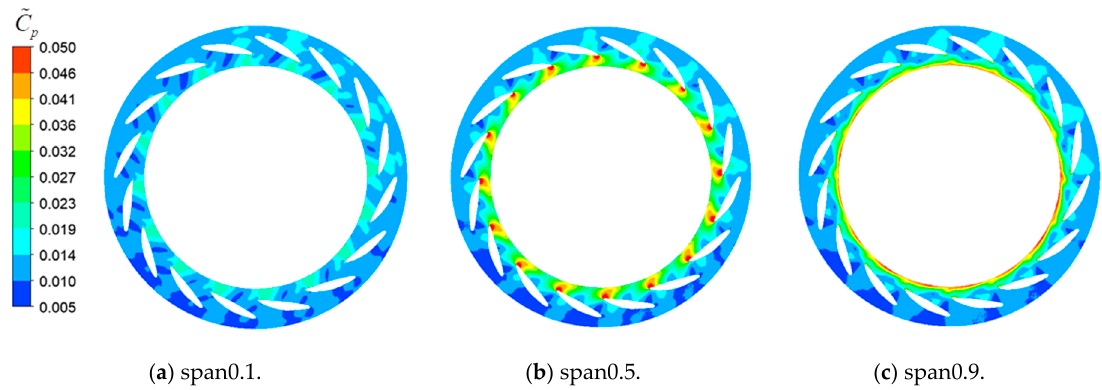
Figure 17. Pressure fluctuation distributions at different vane heights at 0.75 Q d .